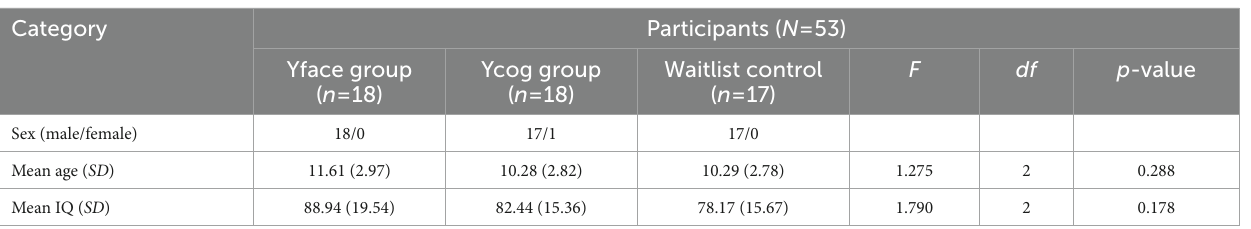
TABLE 1 Distribution of sex, age, and IQ of participants by